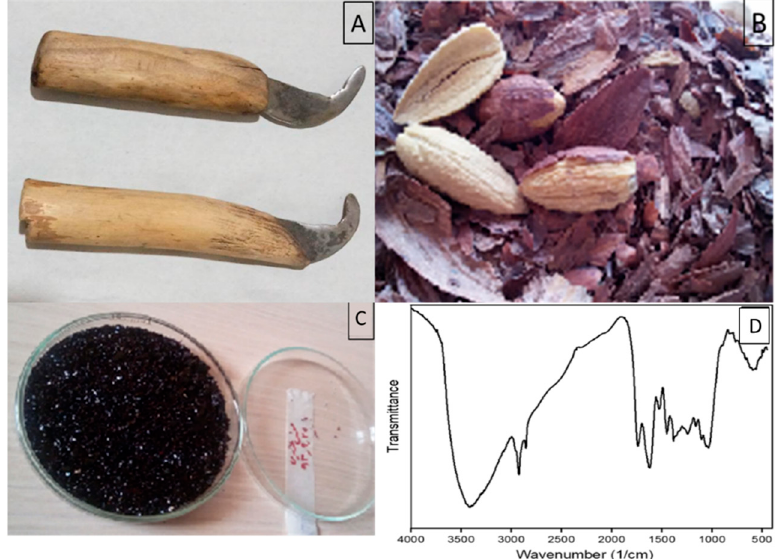
Figure 9. ( A ): Ronjok, ( B ): Oak fruit , ( C ): Jaft, and ( D ): the aqueous extract of Oak fruit .